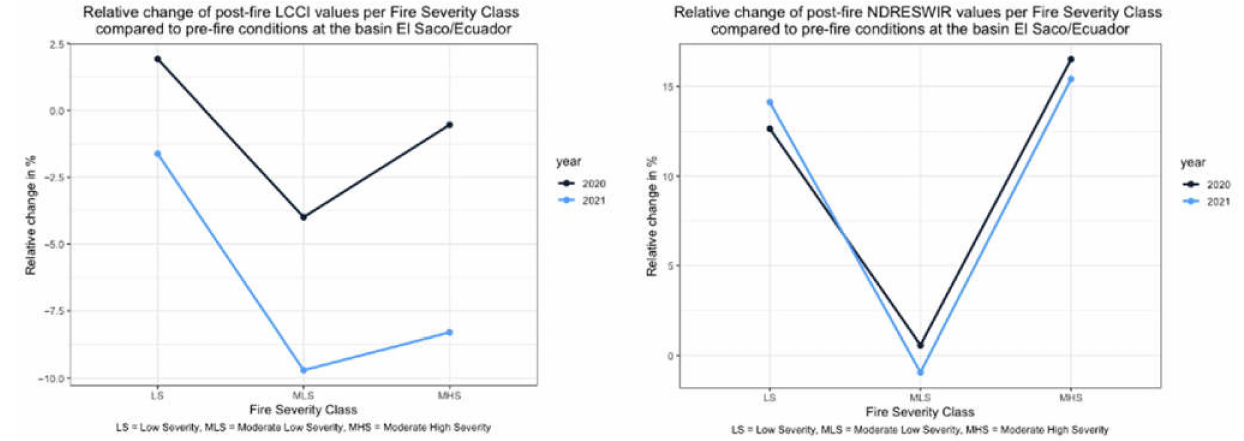
Figure 9. Relative change of post-fire vegetation index values per fire severity class compared to pre-fire conditions at the El Saco